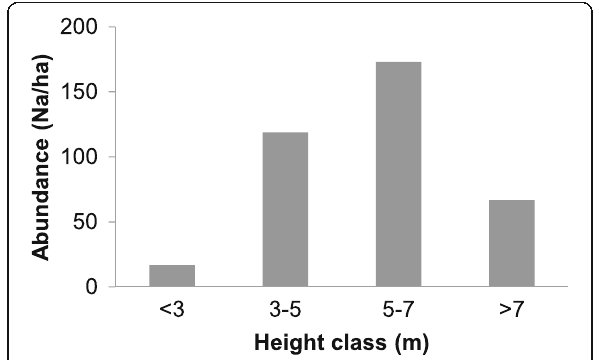
Fig. 2 Absolute abundance (N/ha) of individuals according to height class